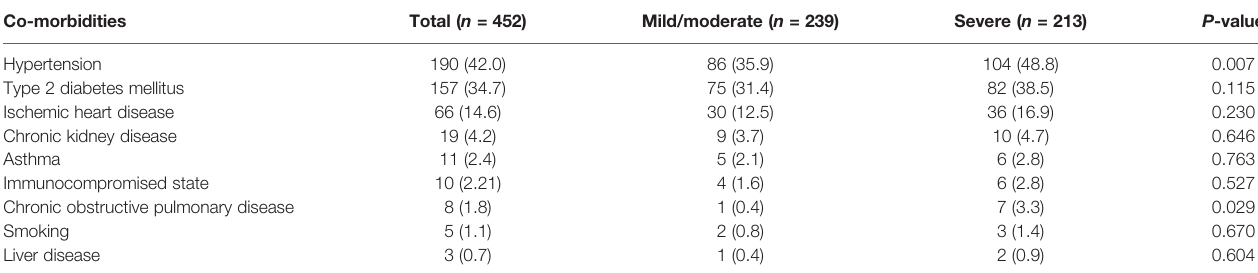
TABLE 3 | Comorbidities of 452 symptomatic COVID-19 patients. Co-morbidities